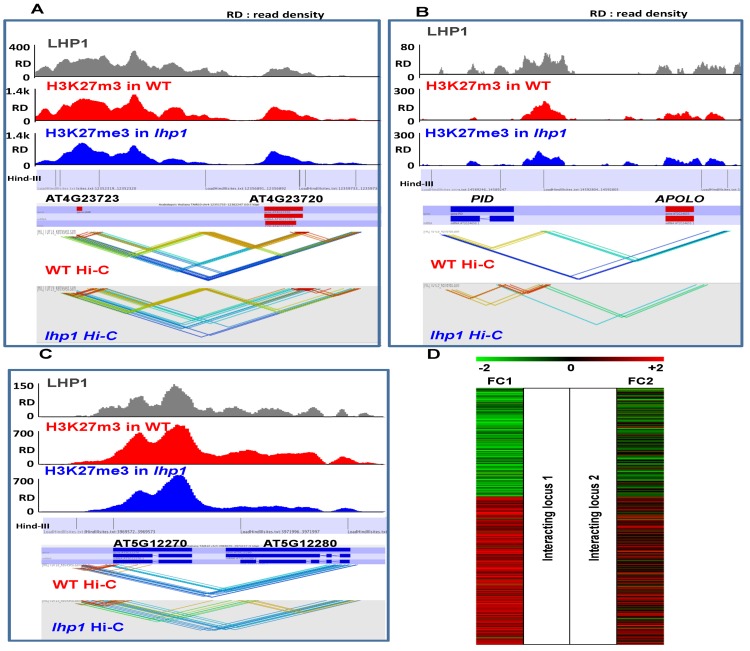
Global changes in chromatin interactions are observed in lhp1, impacting gene transcription.(A) Gene pairs showing altered chromatin interactions and reduced levels of H3K27me3 in lhp1 compared to WT. (B) Hi-C interactions between the pair of gene loci PID and APOLO (chr2:14588900–14599067). Several interactions can be detected between these two loci in WT. These interactions are diminished and even lost (the one in dark blue) in the lhp1 mutant. (C) Genome browser screenshot showing gene pairs revealing loss of chromatin interactions and reduced levels of H3K27me3 in lhp1 compared to WT. For A to C, colors indicate different interactions (red to blue) in cis and in trans (not adjacent Hind III sites). (D) Expression level changes inl hp1 compared to WT of significantly interacting pairs of genes which are LHP1-targeted. Colors were attributed according to the fold-change (FC) observed in the expression level: genes with a log 2 fold change of 2 or above are coloured in red while genes with a log 2 fold change of -2 or lower are coloured in green and genes with a log 2 fold change between -2 and 2 are in black. Interacting pairs show similar transcriptional behavior in the lhp1 background.